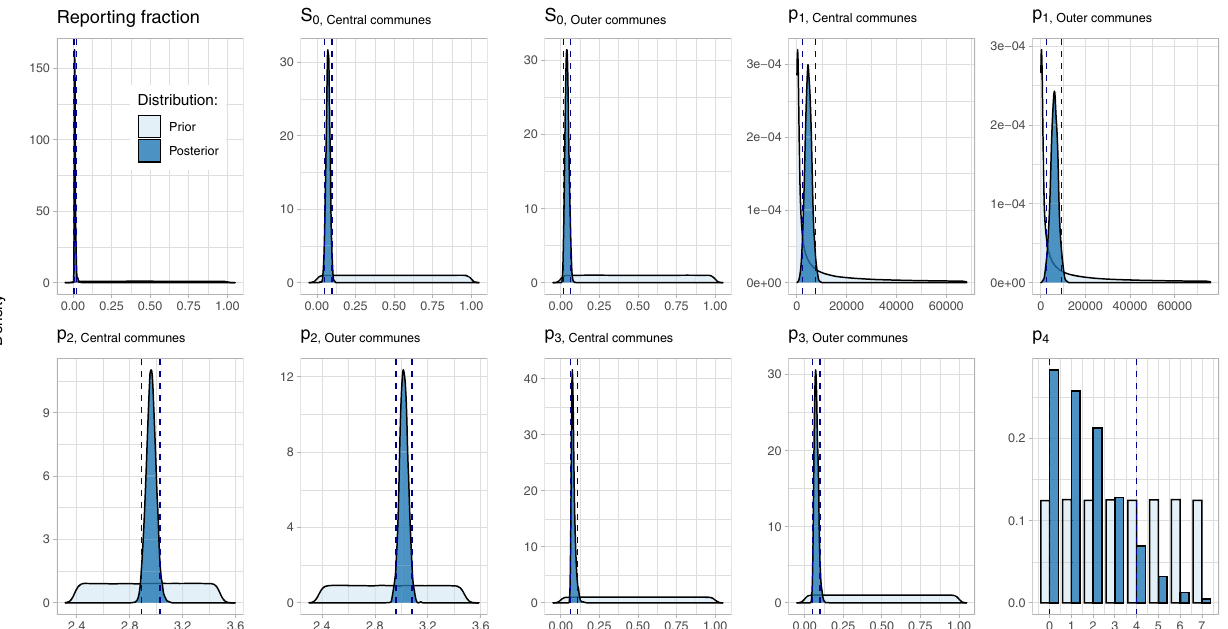
Fig. 2 Prior (light blue) and posterior (dark blue) distributions of the model ’ s parameters estimated by the Markov Chain Monte Carlo algorithm. For each parameter, dashed vertical lines represent the posterior 95% credible interval (highest posterior density